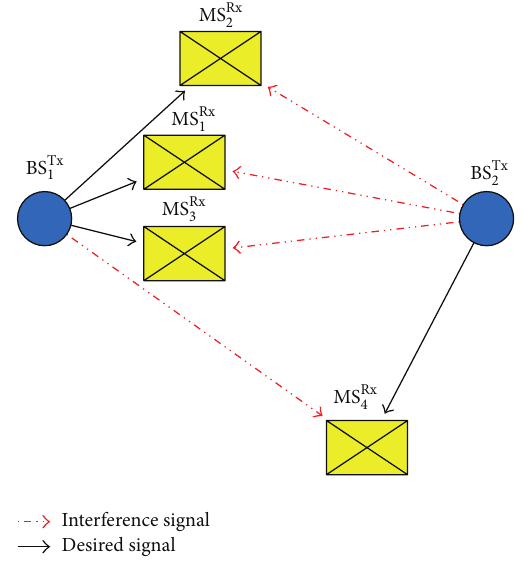
Figure 1: Cochannel interference in OFDMA/TDD